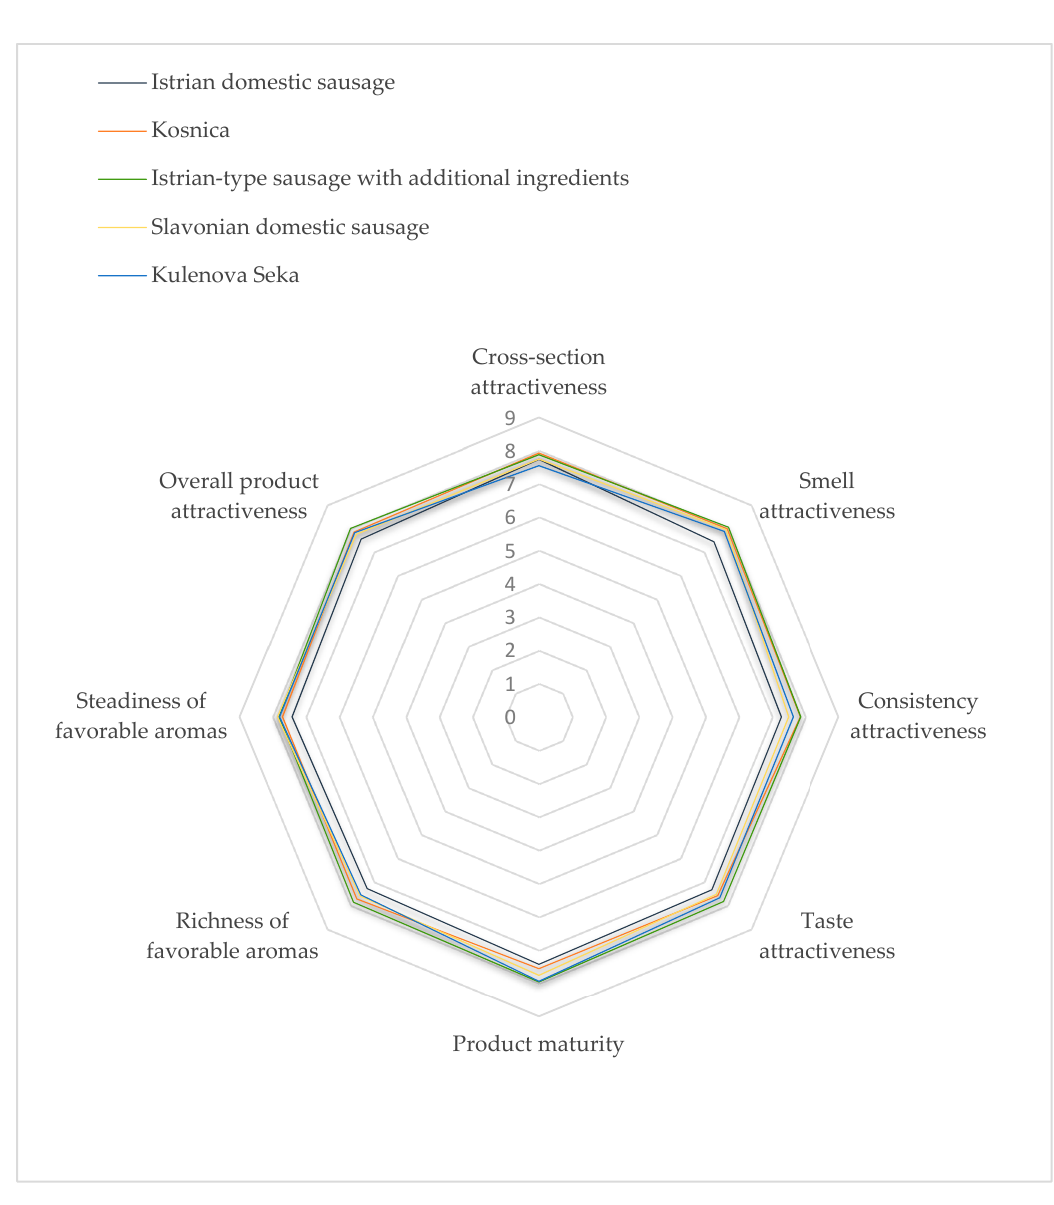
Figure 2. Subjective sensorial characteristics of Croatian traditional sausages.